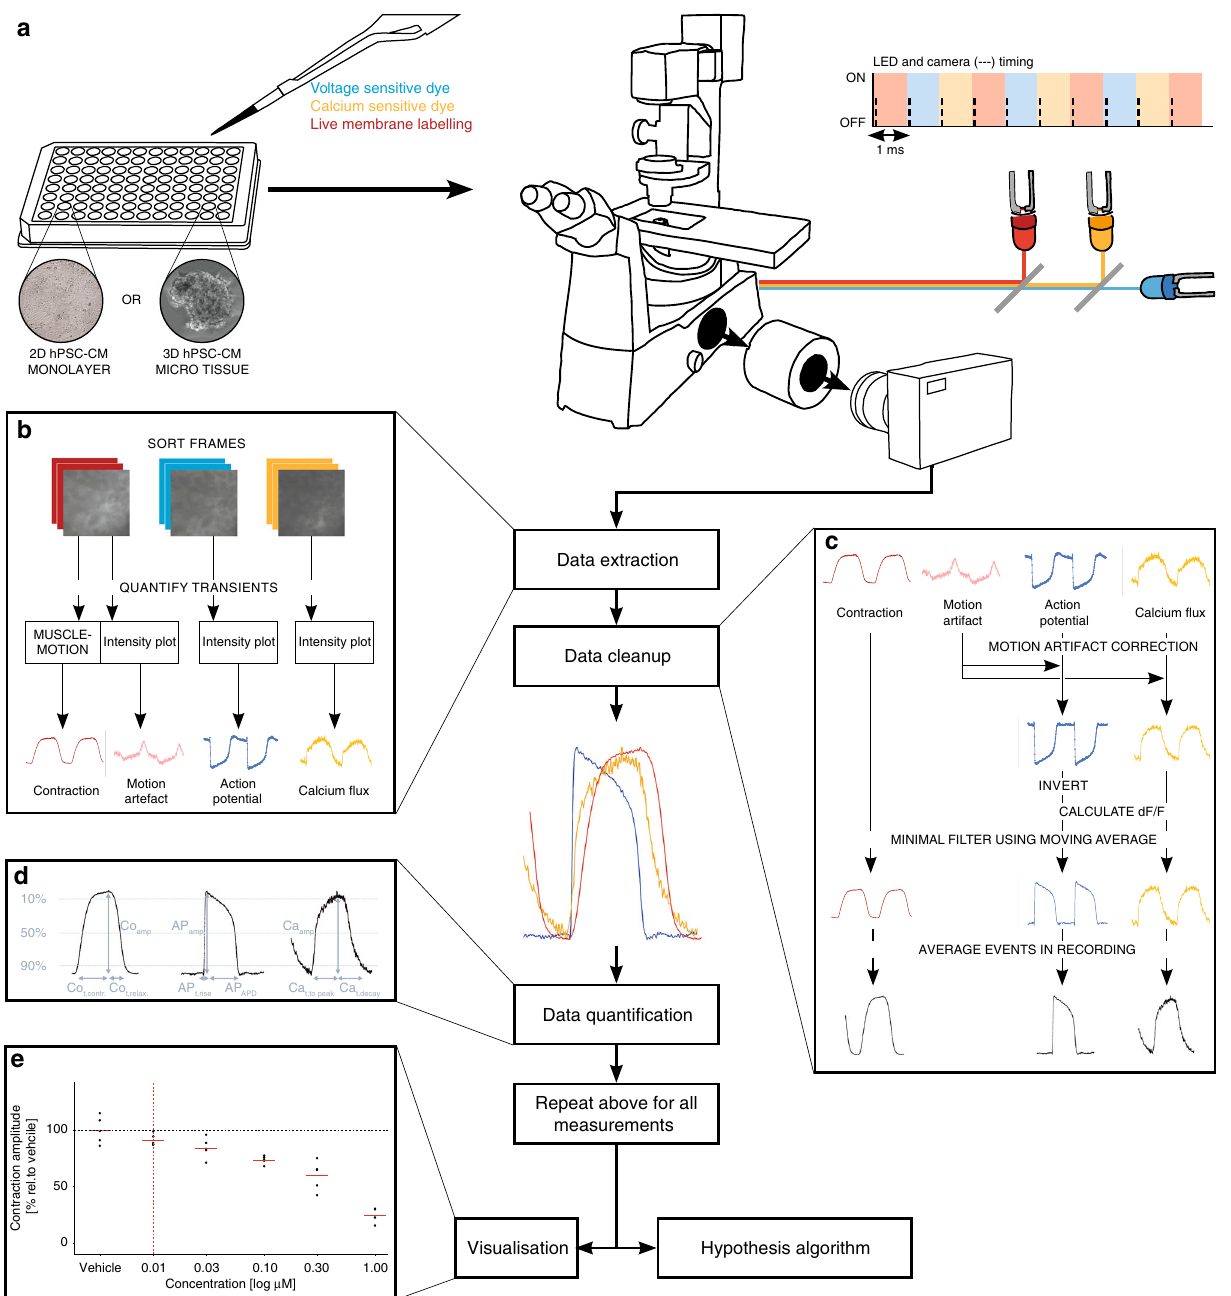
Fig. 3 Triple Transient Measurement system for determining AP, Ca and Co simultaneously. a Hardware setup: the hiPSC-CM model of interest (2D or 3D) is incubated with the voltage sensitive dye (ANNINE-6plus), calcium sensitive dye (Rhod 3) and cell membrane label (CellMask Deep Red) used for measuring contraction. The hiPSC-CMs are excited using three rapidly alternating LEDs which are synchronized with a high-speed camera. The camera receives the emitted signal from the hiPSC-CMs after photon ampli fi cation by the image intensi fi er. The data are then fed into the data processing pipeline. b The video frames are split into three stacks that contain the information regarding the AP (blue), Ca (yellow) and Co (red). The information of each stack is extracted by either plotting the intensity changes and/or applying MUSCLEMOTION. c The data are then “ cleaned ” to remove the motion artefacts, invert the signal when necessary, calculate Δ F/F, apply a minimal fi lter and/or average the events within one recording. d The data are quanti fi ed by summarizing the kinetic parameters of interest determined in Table 1. e Finally, the data are plotted and meanwhile fed into the hypothesis Data extraction and processing . For each measurement point, image intensity plots are extracted from all three image stacks (Fig. 3b). This yields the raw AP signal, Ca signal and the motion 7 s of recording were made at 1000 fps using a spatial resolution artefact (MA) signal. Since CellMask Deep Red (i.e. the fl uor- of 720 × 720 pixels yielding a fi le size of 3.6 GB. This large ophore that is the origin of the MA signal) is colocalized with the amount of data is then handled using automated data processing VSD in the membrane of the hPSC-CMs and recorded simulta- algorithms. First, the total fi le is split into three separate stacks neously with the VSD signal, we could use the MA signal for corresponding with the three transients AP, Ca and Co. Next, the